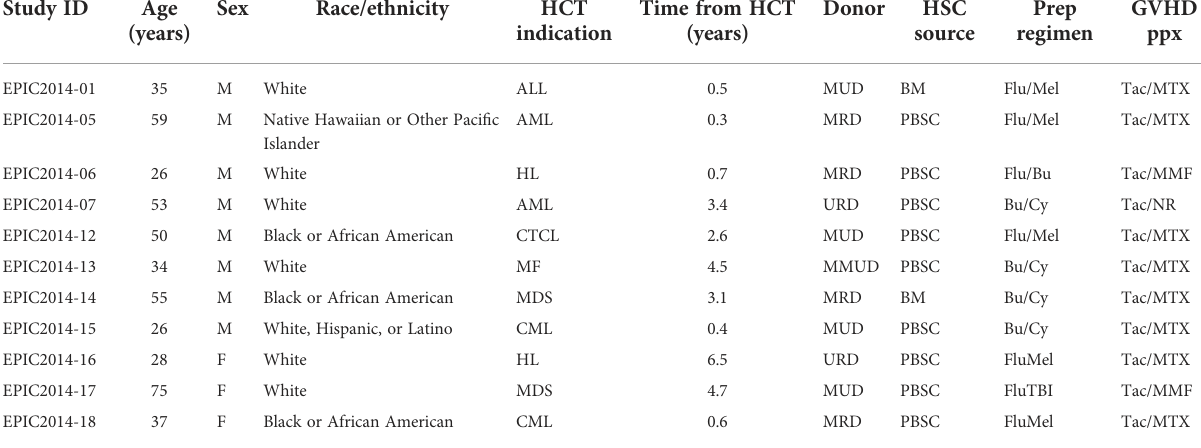
TABLE 1 Baseline patient, disease, and HCT